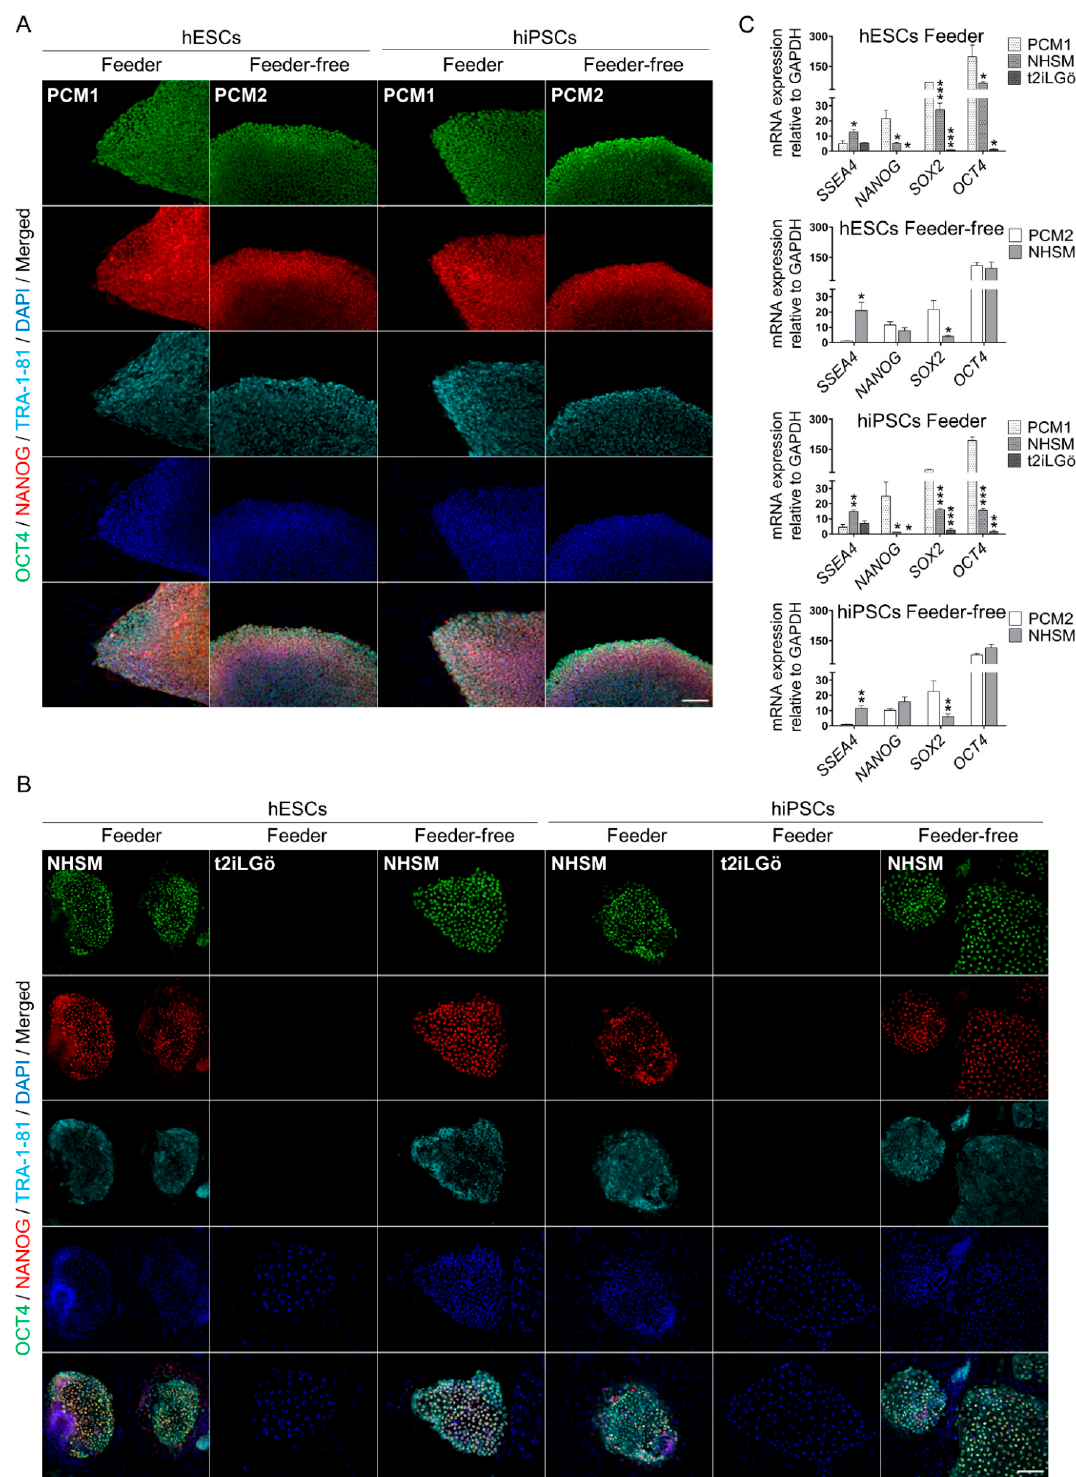
Figure 3. Assessment of primed and naive hPSCs (hESCs, hiPSCs) pluripotency in different culture media conditions. ( A , B ) Immunofluorescence analysis of pluripotent capacity specific markers (OCT4, NANOG and TRA-1-81) on primed and naive hPSCs on feeder and feeder-free cultures. Scale bar, 100 µ m. ( C ) Gene expression analysis for pluripotency specific genes ( SSEA4 , NANOG , SOX2 and OCT4 ) on feeder and feeder-free hPSCs cultures. All comparisons are relative to primed media (* p < 0.1, ** p < 0.01 and *** p < 0.001). Data are represented as mean ±